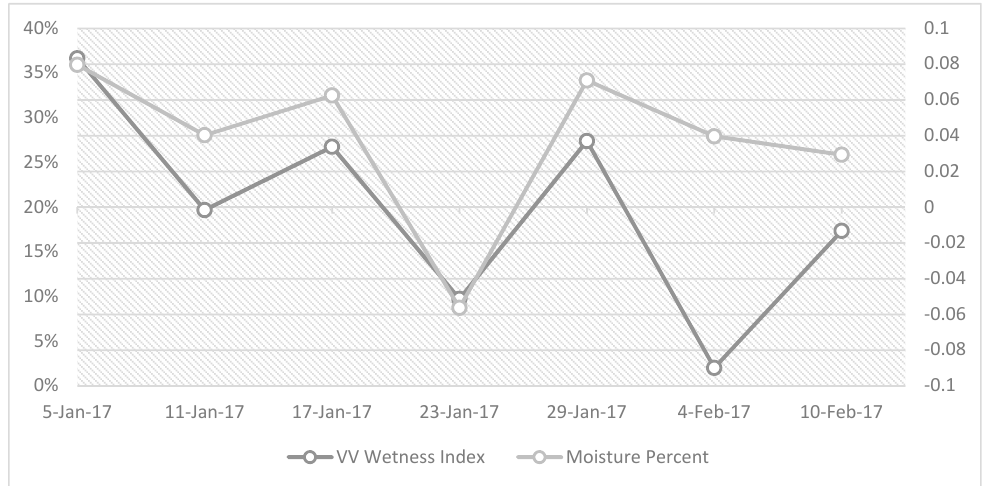
Figure 4. Plot 3 soil water content variability. The following are readings from Test Plot 3 in An Giang province, in which the farmer uses AWD management practices. It shows the VV-WI, and moisture percent readings for the plot. The two factors show a strong correlation (r = 0.65).